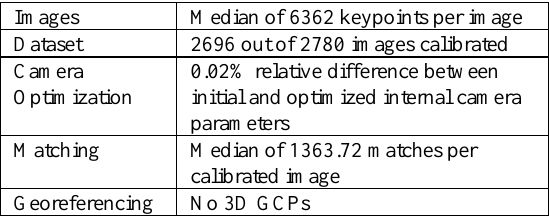
Table 4. Image quality